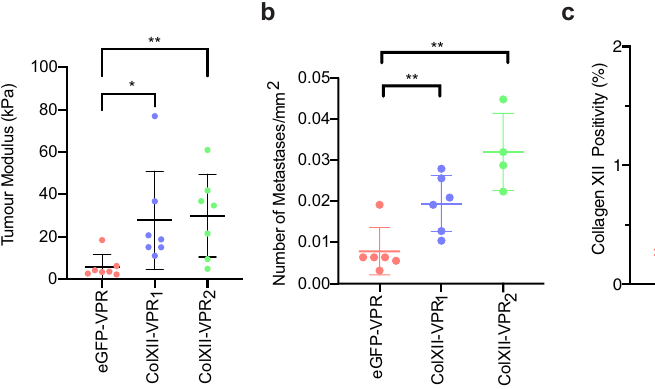
VPR 2 p =0.0048,two-sidedMann – Whitney U -test. c Quanti fi cation ofcollagen XII- positive area in primary tumours from the overexpression study. n =7 eGFP-VPR mice, n =7 ColXII-VPR 1 and n =8 ColXII-VPR 2 mice. ** p <0.01, eGFP-VPR vs. ColXII- VPR 1 p =0.0098; eGFP-VPR vs ColXII-VPR 2 p =0.025, two-sided Mann – Whitney U - test. One-way ANOVA with a Dunnett ’ s multiple comparisons test. Data are pre- sented as mean±SD. d Quanti fi cation of pMLC2 positive area in primary tumours from the overexpression study. n =7 eGFP-VPR mice, n =7 ColXII-VPR 1 and n =8 ColXII-VPR 2 mice.* p =0.04,two-sidedMann – Whitney U -test.Dataarepresentedas mean±SD. Source data are provided in the Source data fi